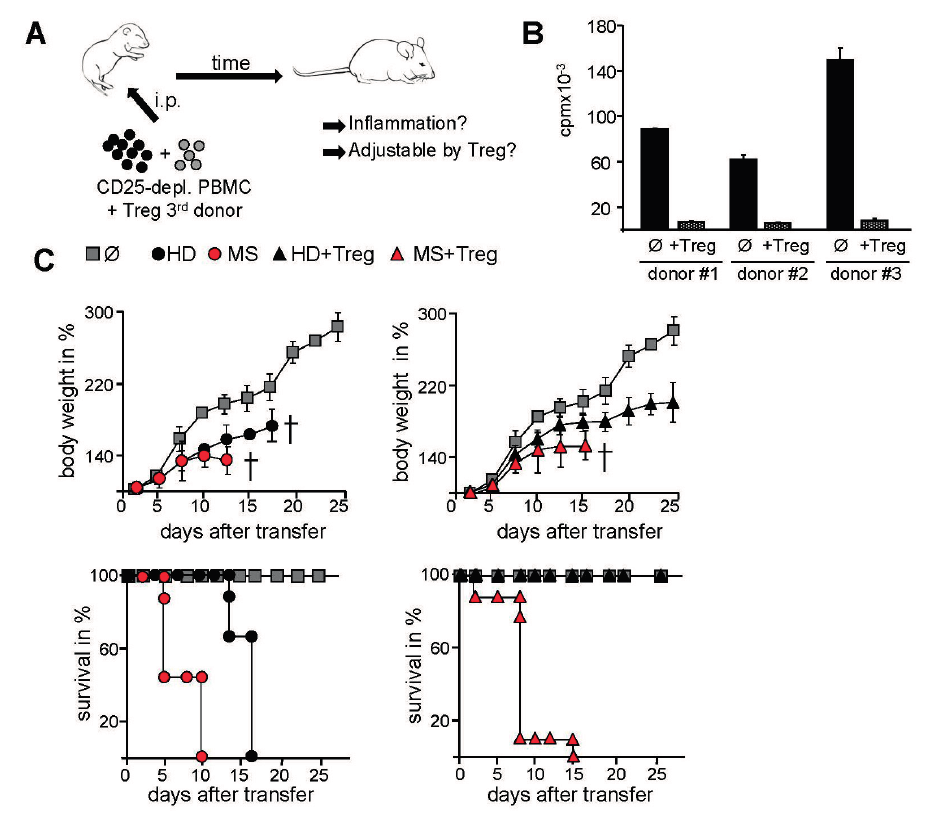
Figure 2. Transferring human PBMC of MS patients into newborn immunodeficient mice resulted in a severe systemic inflammation without protection by activated